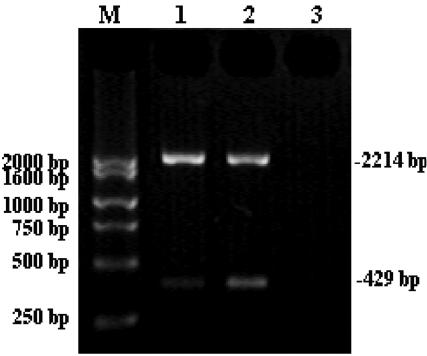
Figure 1. RT-PCR ampli fi cation using cDNA templates from two acute leukemia (AL) patients revealed an expected 2214-bp band and an unexpected 429-bp band representing differential splicing. Lanes: M: molecular size markers; 1 and 2: the two AL patients; 3: negative